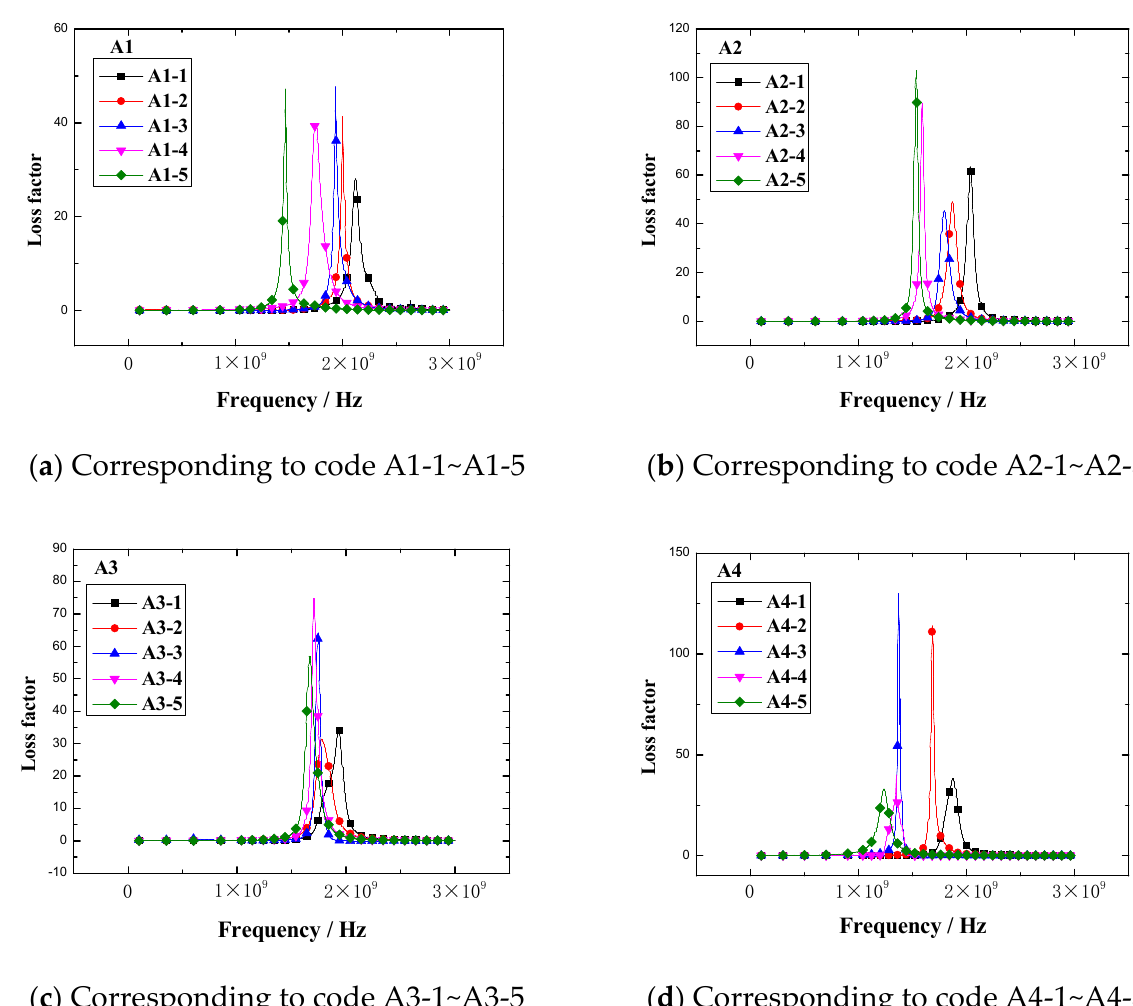
Figure 11. The loss factor vs. frequency plots of the rubber samples.